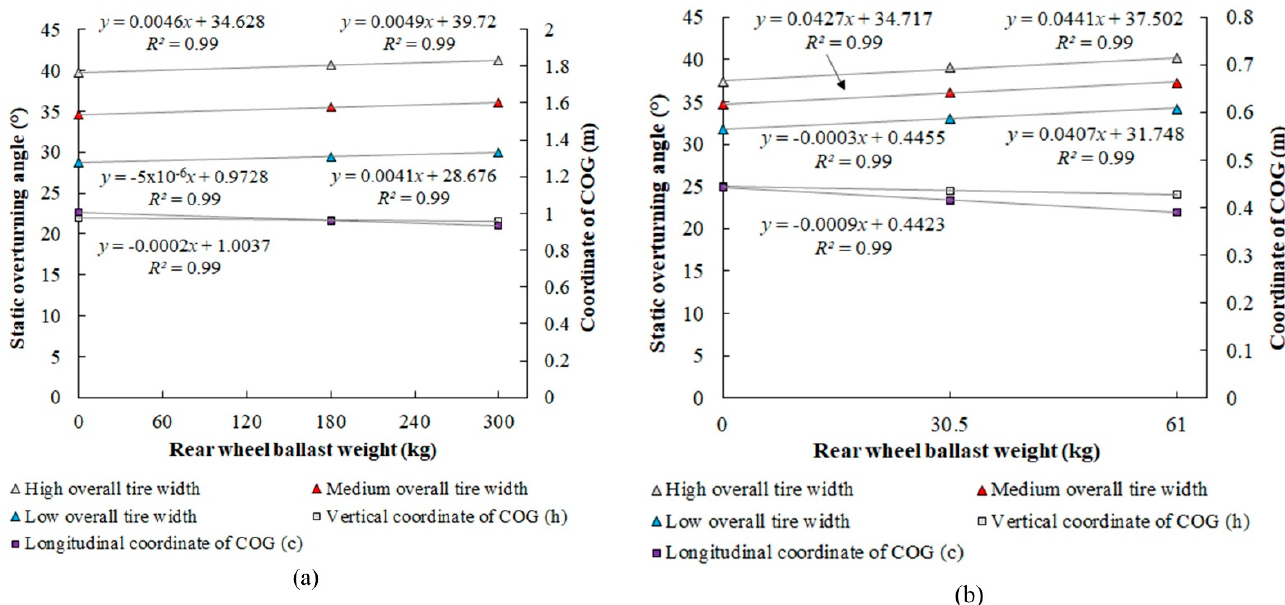
Figure 9. Static overturning angle calculated according to [14] and coordinates of COG: ( a ) Universal tractor; ( b ) Subcom- pact tractor.